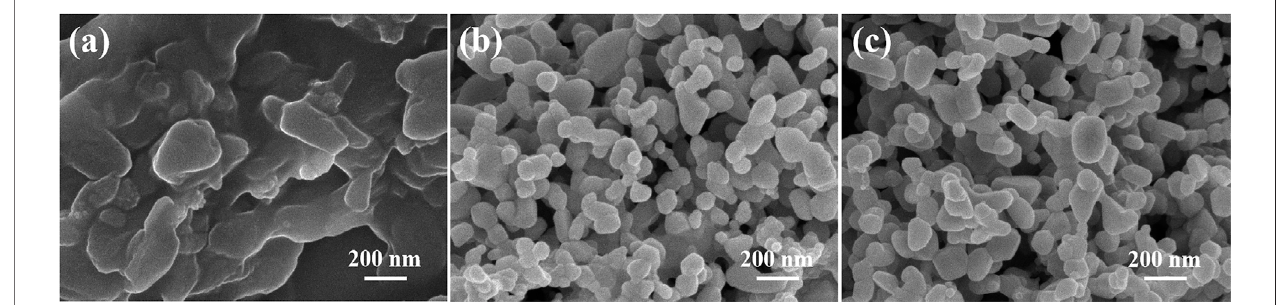
FIGURE 3 | SEM images of (A) MIL-125(Zn), (B) ZnO, and (C) Ag/ZnO.